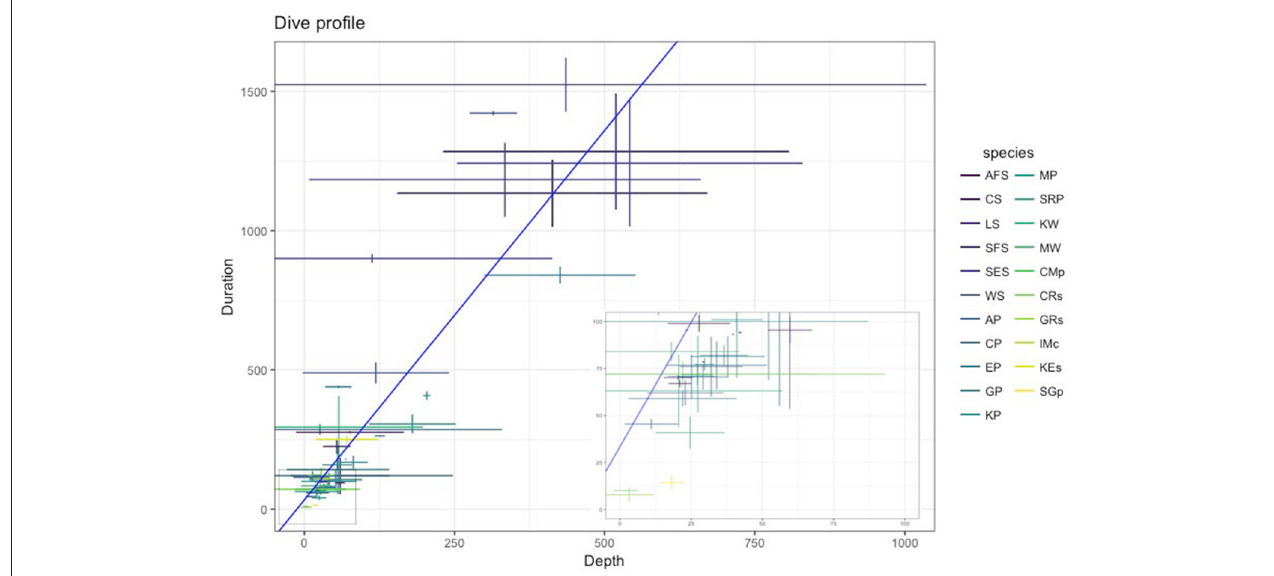
FIGURE 4 | The relationship between dive duration (s) and depth (m) across the most commonly researched SO marine predators described in Table 2 (species abbreviations given in table). Values shown as mean ± SD. Inset panel provides a closer look at shorter ( < 100s) and shallower ( < 100m) dives. Data collected from studies undertaken between 2006–2016 (see Supplementary Material